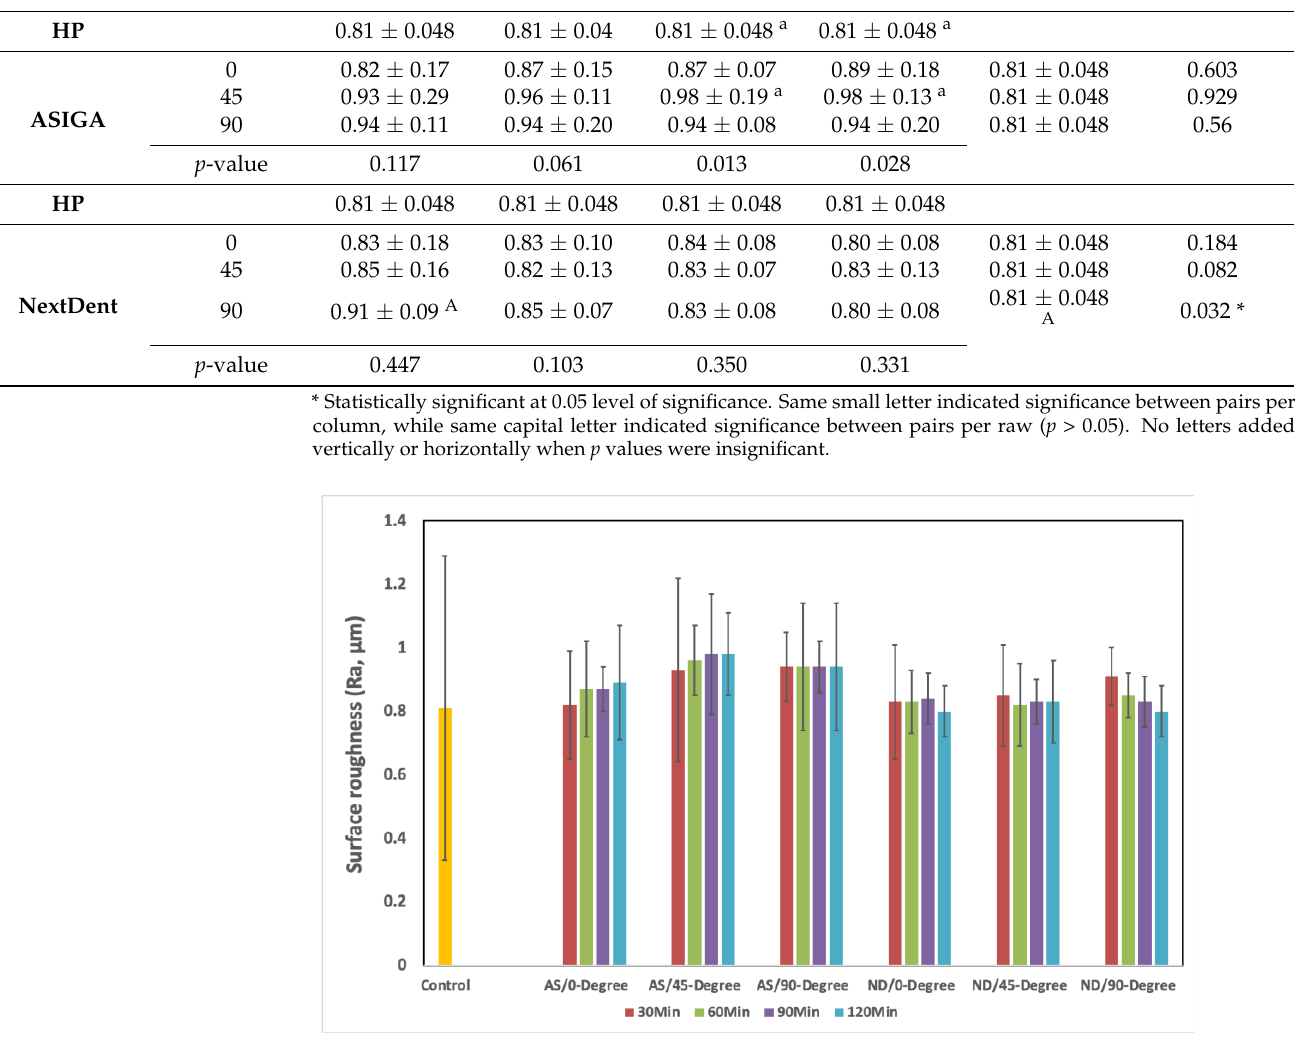
Figure 5. Mean and SD of surface roughness (Ra, µm) of all tested groups.